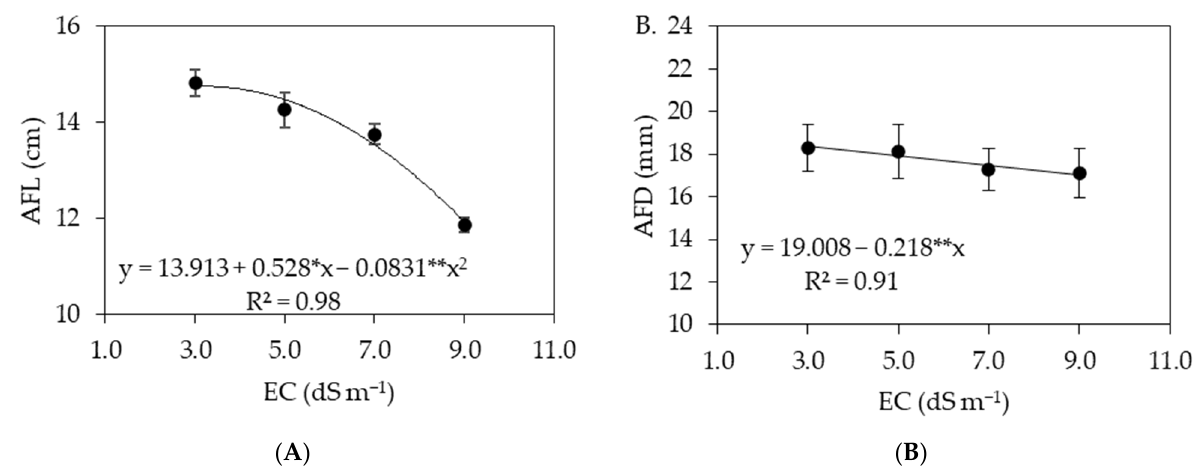
Figure 17. Average fruit length ( A ) and average fruit diameter ( B ) of ‘Canindé’ okra cultivated in a hydroponic system as a function of the electrical conductivity of the nutrient solution (EC) 60 days after transplanting. * and ** significant at p ≤ 0.05 and ≤ 0.01, respectively. The vertical lines represent mean +/ − standard error (n =